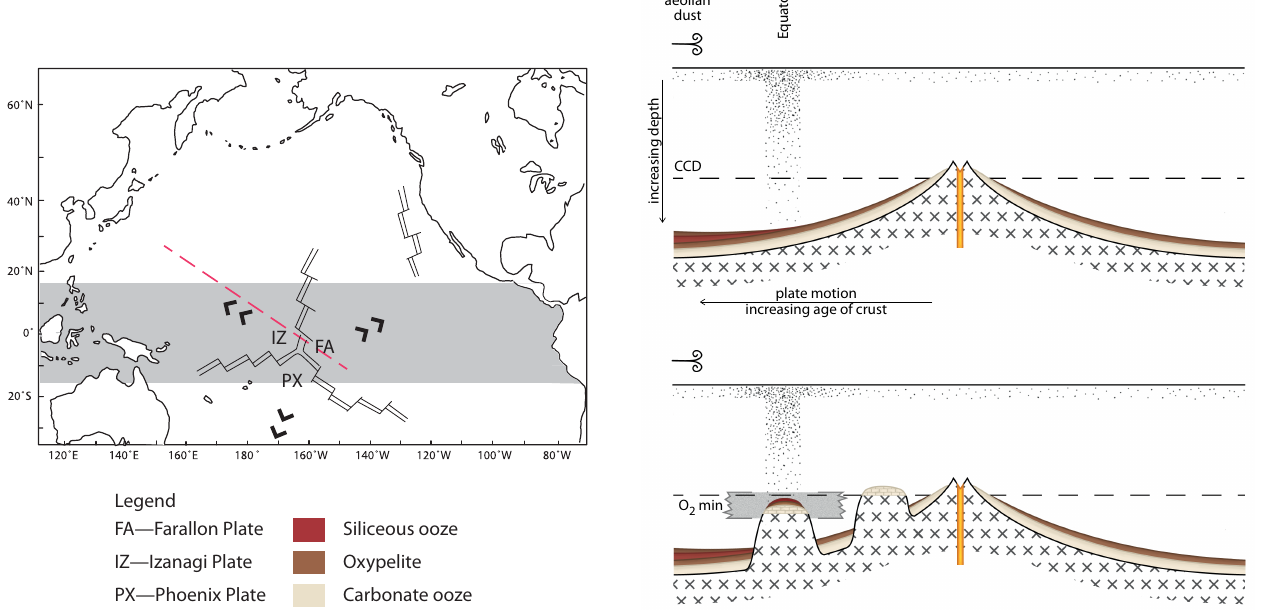
Fig. 7. (A) Present-day map of the Pacific region with Early Jurassic plate tectonic elements. The red dashed line shows the position of the cross-sections shown in panels B and C. Movement of tectonic plates indicated by arrows. The equatorial divergence zone is shown in grey. Base map modified from Robinson et al. (2004) and plate tectonic elements from M¨uller et al. (2008). (B) Schematic cross-section across the Early Jurassic Panthalassa showing the abyssal seafloor hypothesis for the formation of organic matter-rich chert. Izanagi Plate on the left. CCD stands for calcite compensation depth. The dotted pattern represents particulate matter. (C) Schematic cross-section across the Early Jurassic Panthalassa showing the mesopelagic/upper bathyal seamount hypothesis for the formation of organic matter-rich chert. The seamount is transported by seafloor spreading from right to left in the figure, i.e. towards the northwest in panel